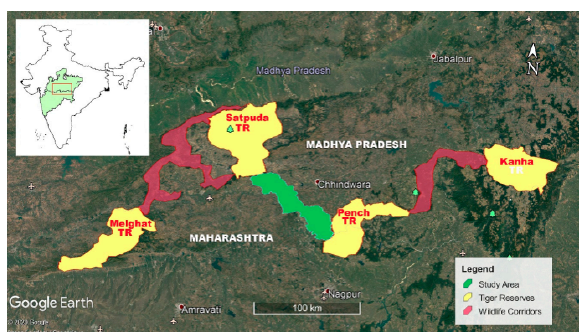
Figure 1: Google Earth image showing the important tiger re- serves of central India and with their corresponding linkages, the green and the red portions that link the national park’s are the study area for our research. Source: [Banerjee et al., 2020] wildlife tiger migration and connectivity zones for the ”Critically protected complex” in the state of Madhya Pradesh.